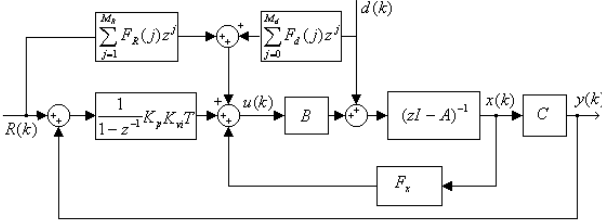
Fig. 4. Preview feed forward compensation system structure.